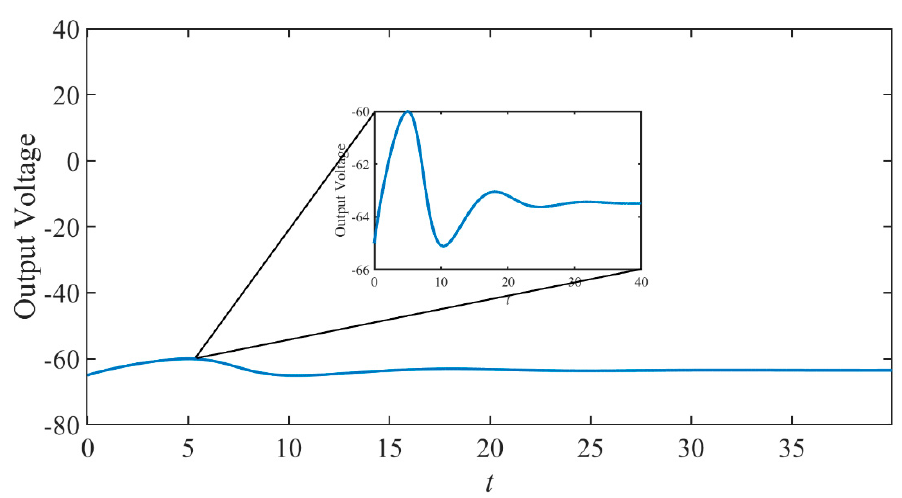
Figure 2. The response is when the input is less than the threshold. When the applied pulse current value is greater than the threshold and the pulse current is 3 mA, the output voltage waveform is shown in Figure 3. It can be seen from the figure that the output voltage suddenly increases.